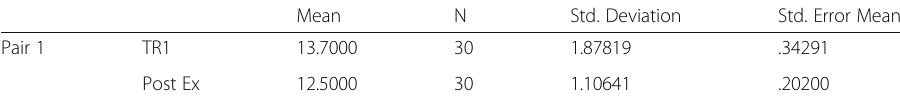
Table 15 Descriptive statistics of the posttest of Ex. and TR1